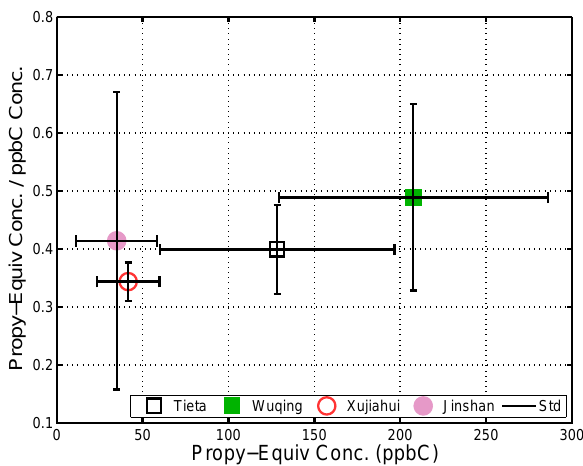
Fig. 3. NMHC reactivity at each site of Tianjin and Shanghai. Mark- ers represent average Propy-Equiv concentrations during the sam- pling period (x-axis), as well as the ratio of Propy-Equiv concen- tration to carbon-atom based concentration (y-axis). Standard devi- ations are given in black